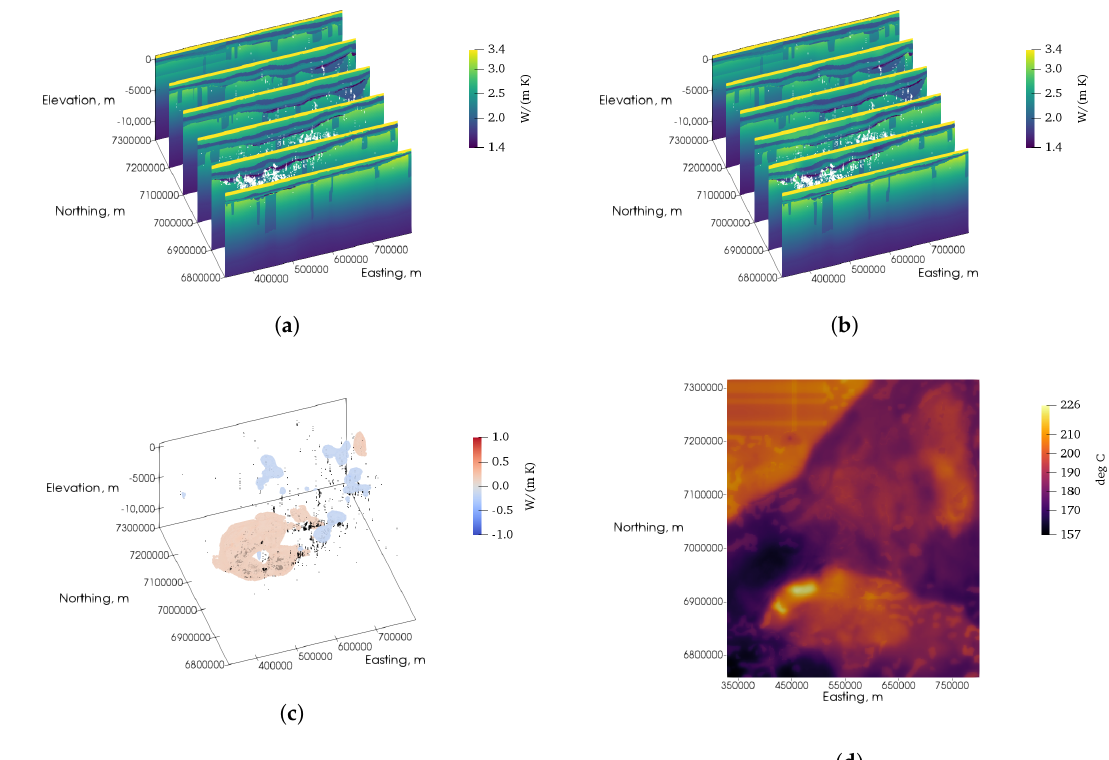
Figure 9. ( a ) Cross-sections of a thermal conductivity model published by Meixner et al. [38] which was used as a reference model in the second inversion, with a vertical exaggeration factor of 20. Data locations are shown in white. ( b ) Cross-sections of an inversion of OZTemp borehole temperature data, using the model in Figure 9a as reference model, with a vertical exaggeration factor of 20. Data locations are shown in white. ( c ) The inverted thermal conductivity model minus the reference model, thresholded to show differences larger than 0.15Wm − 1 K − 1 . Data locations are shown in black. The model is slightly transparent to permit all data locations to appear. ( d ) Plan view of predicted temperature at 4 km depth, using the thermal conductivity from Figure